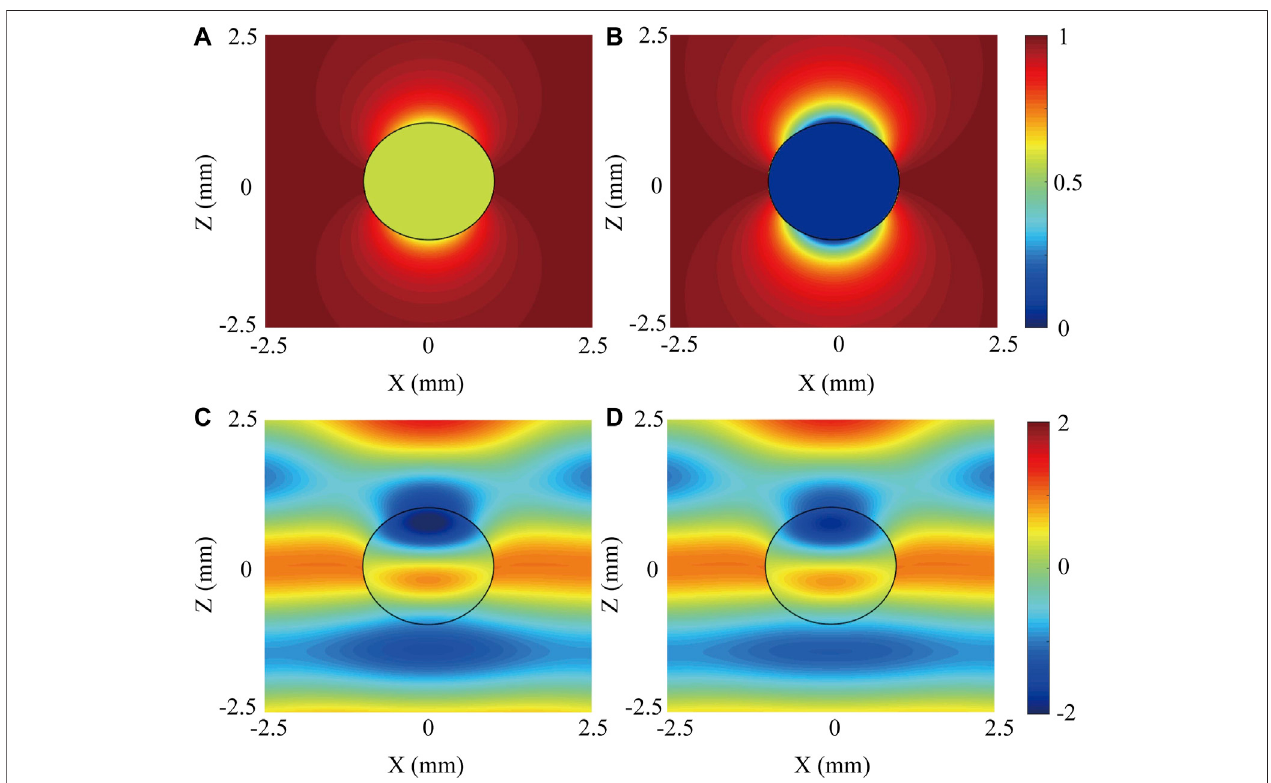
FIGURE2| Fielddistributionsofneutralandchargedparticles.The x componentoftheelectric fi eldat1 GHz (upperpanel) and100 GHz (lowerpanel) for (A,C) a neutral particle and (B, D) a charged particle with surface charge density η s (cid:1) 100mC/m 2 . The particle with a relative permittivity of 3.2 and a radius of 1 mm is illuminated by a plane wave polarized in the x direction and propagating in the z